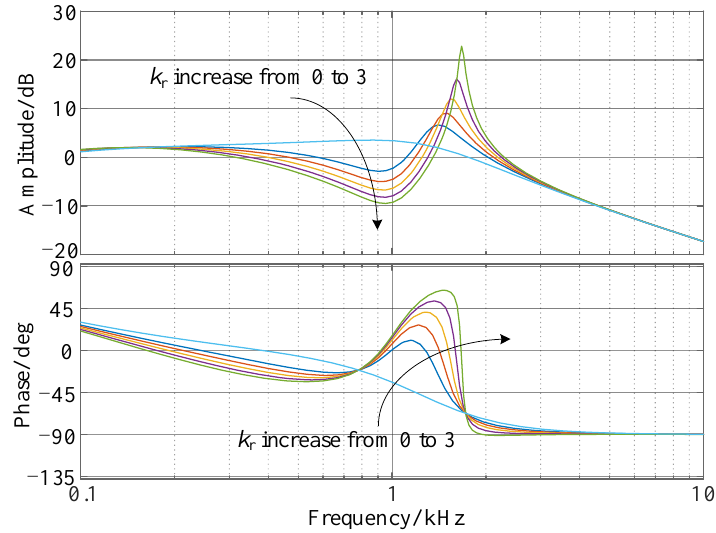
Figure 13. The bode plot of G u_i ( s ) with resonance controller under different k r .